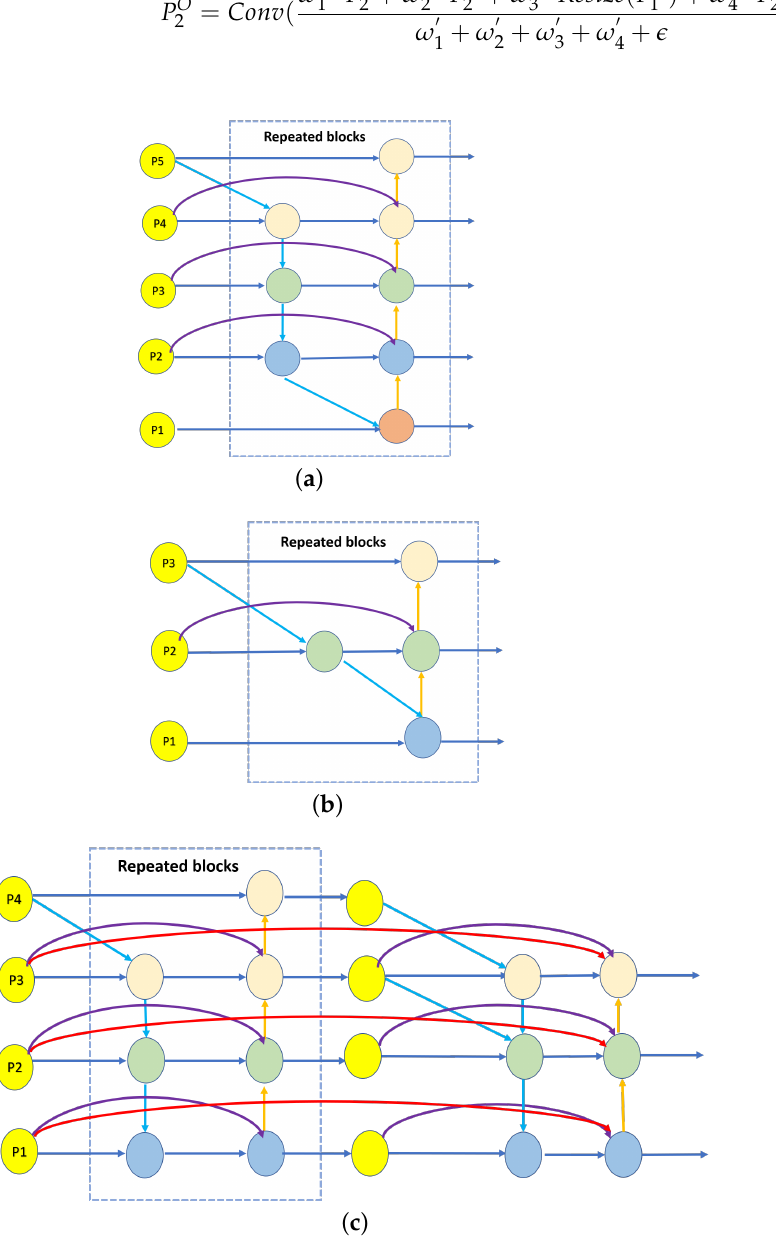
Figure 5. ( a ) Original BiFPN; ( b ) 3-level input and output BiFPN; ( c ) our improved